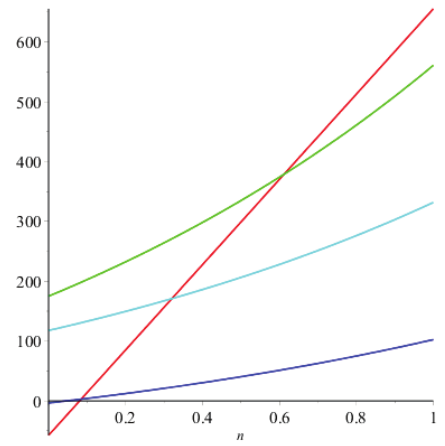
Figure 8: AG Index.